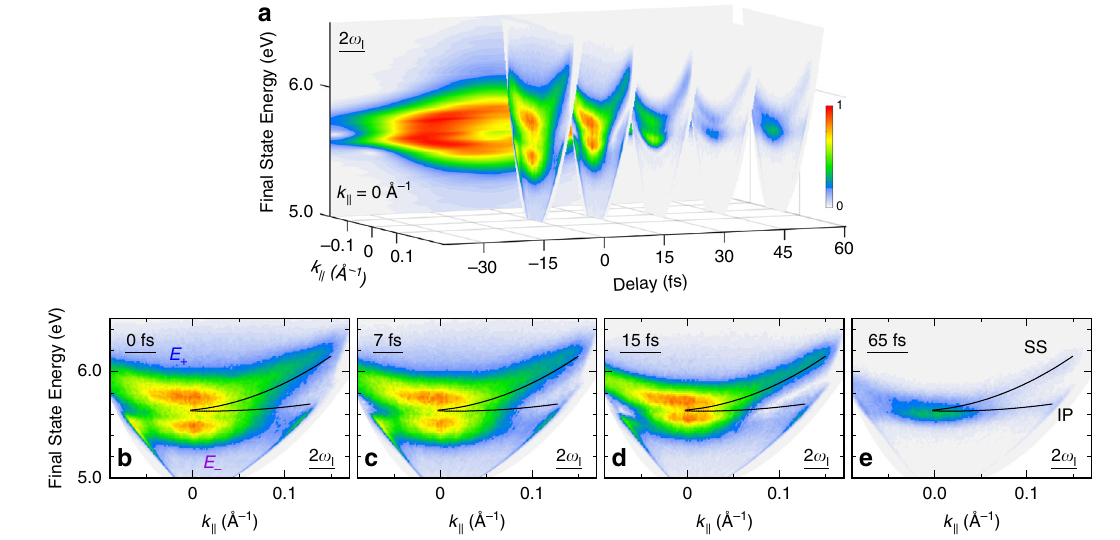
Fig. 3 Real-time movie of the k || -dispersion-optical fi eld entanglement. a IFT of the 2 ω l -polarization component in Supplementary Movie 1 (also, the Fig. 1a data) provides a 3D presentation of the E f ( k || , τ )-resolved AT doublet (the individual movie frames show the E f ( k || )-spectra in 15 fs intervals; the entire fi ltered data are presented in Supplementary Movie 2). The back panel is the τ -dependence of the IFT E f ( k resolved snapshots for τ = 0, 7, 15, and 65 fs showing undressing as τ is increased. As a reference, the black lines indicate dispersions of the undressed SS and IP1 bands obtained at τ = 100 fs from the un fi ltered ITR-4PP data, where the dressing is